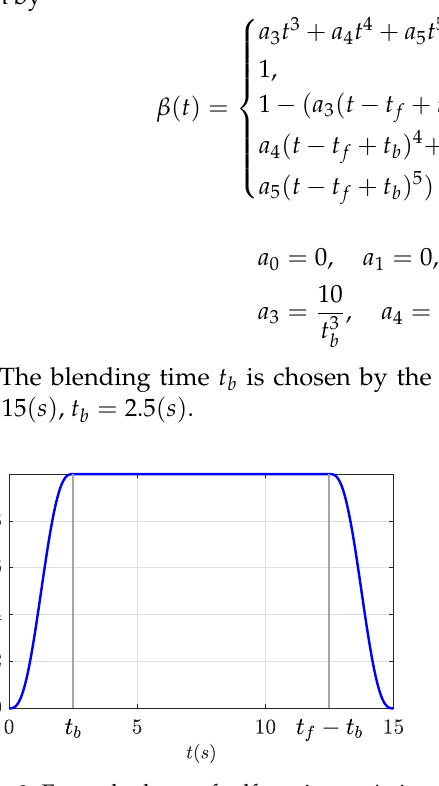
Figure 3. Example shape of self-motion variation factor β